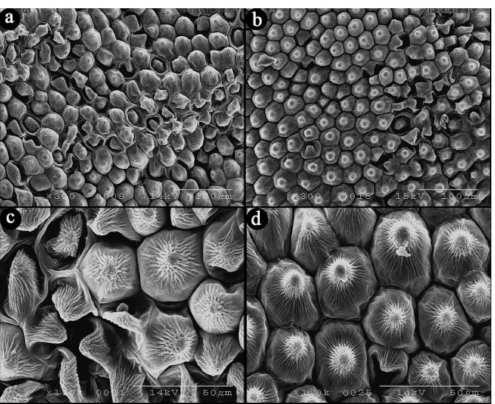
Figure 6. The anatomical structure of upper epidermis of ‘Carolla’ petals during heat stress from ( a ) control (CK, H 2 O), 100 µ m scale bar ; ( b ) T2 (100 µ M CaCl 2 ), 100 µ m scale bar; ( c ) control (CK, H 2 O), 50 µ m scale bar, and ( d ) T2 (100 µ M CaCl 2 ), 50 µ m scale